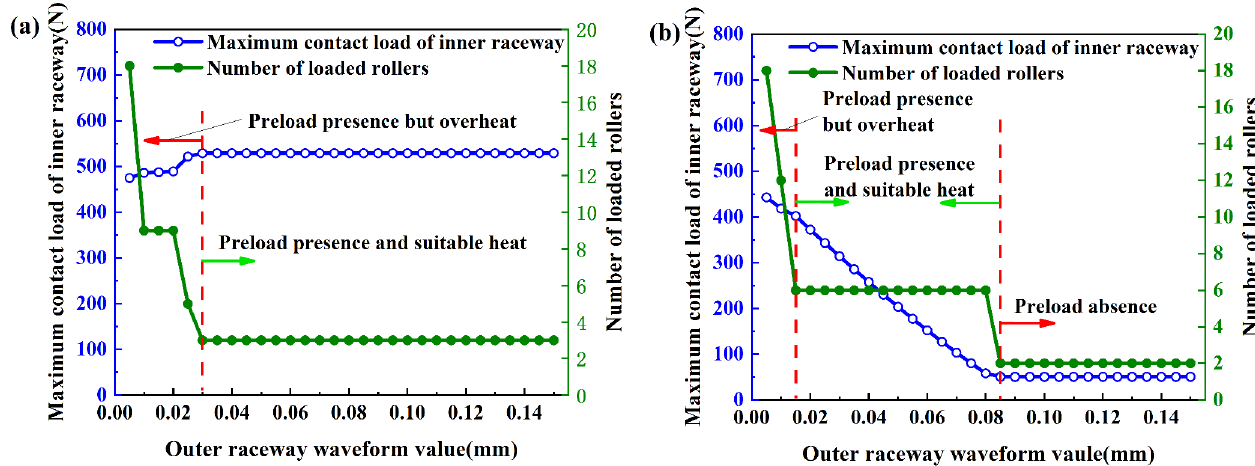
Fig. 8. The maximum contact load variation of the inner raceway and the number of loaded rollers variation under the different outer raceway waveform values: (a) single-pressed state; (b) double-pressed state.